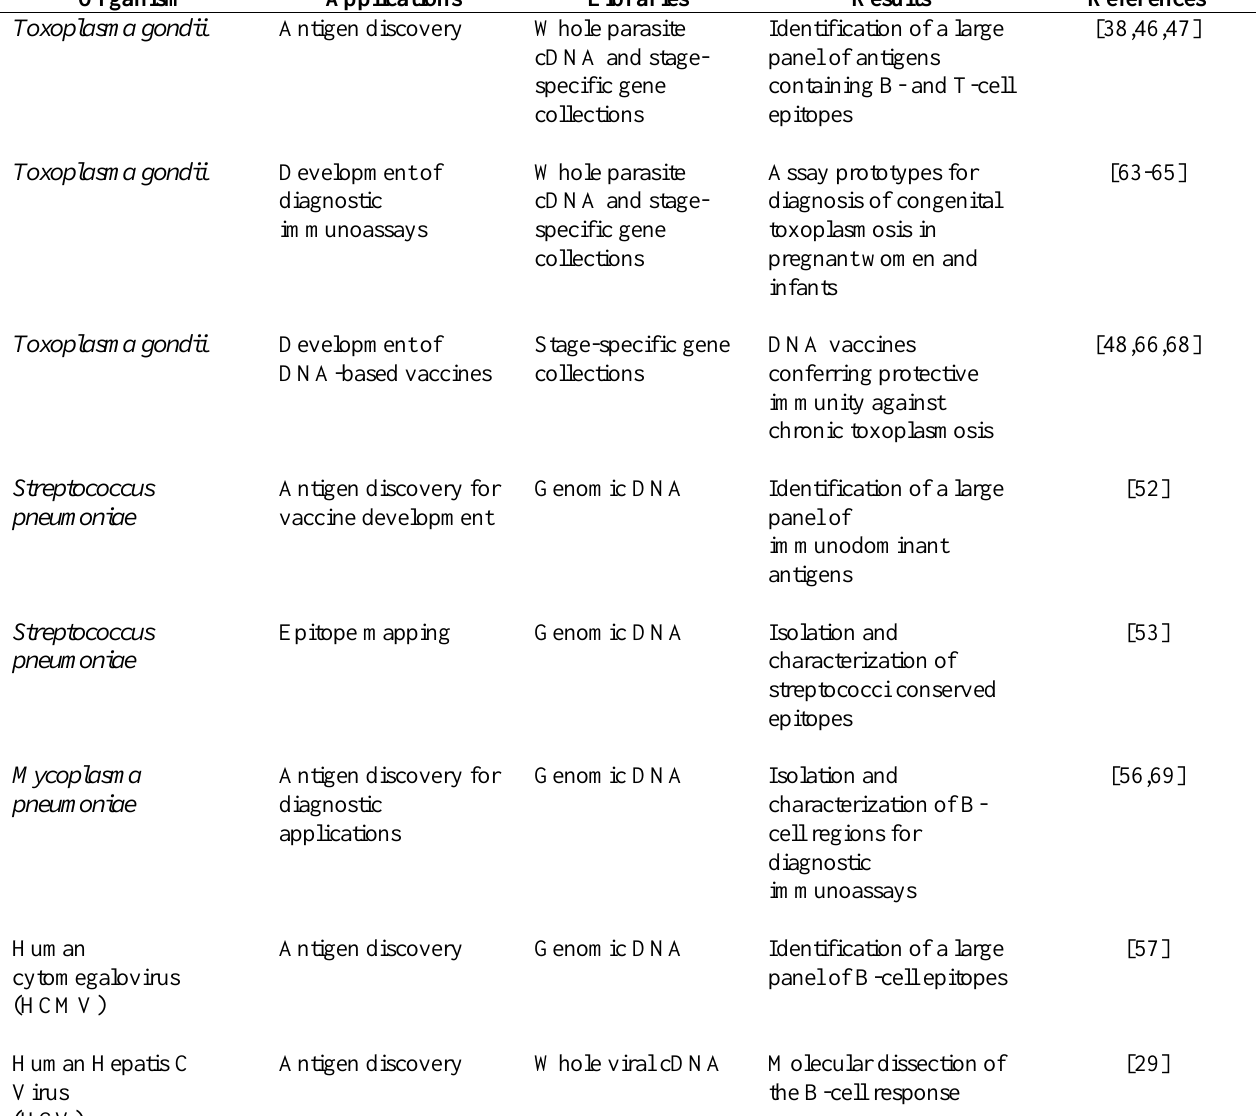
Table 1. Use of lambda-display libraries for antigen discovery and diagnostic